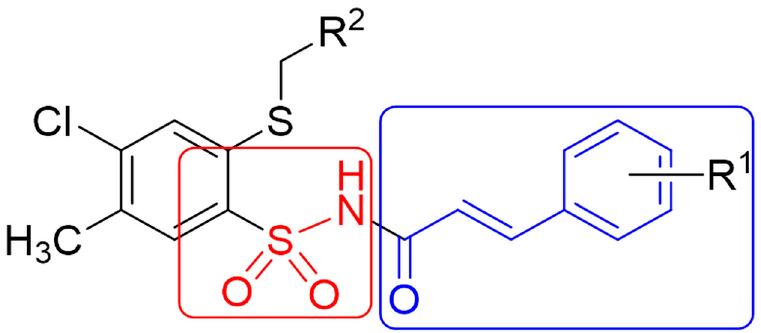
Figure 1. Structure of cinnamic acid and sulfonamide hybrids.